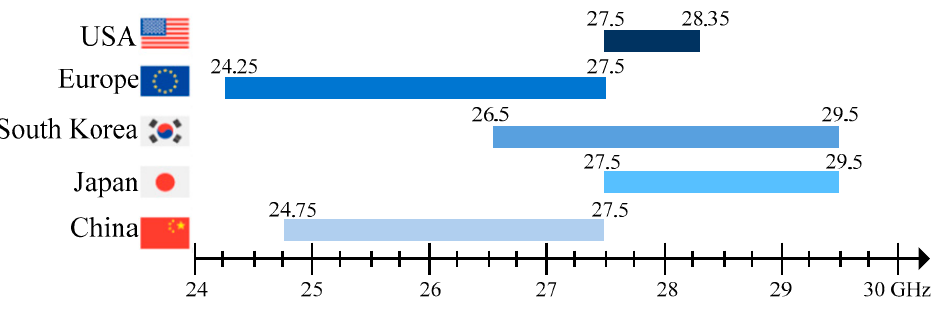
Figure 1. Global snapshot of the 5G millimeter-wave spectrum.